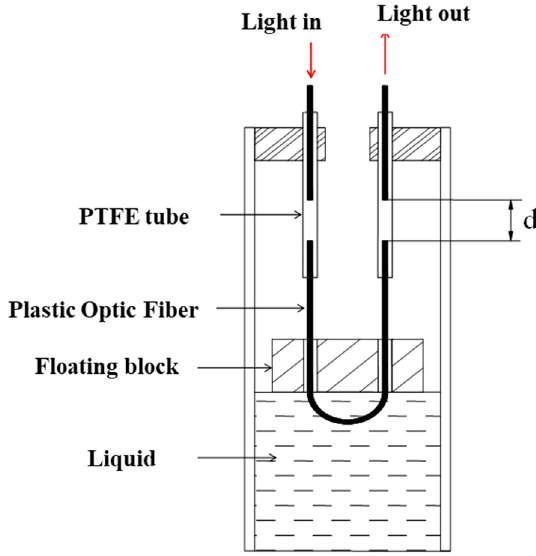
Figure 2. Optical-fiber-based liquid sensor setup. Note: PTFE = polytetrafluoroethylene.